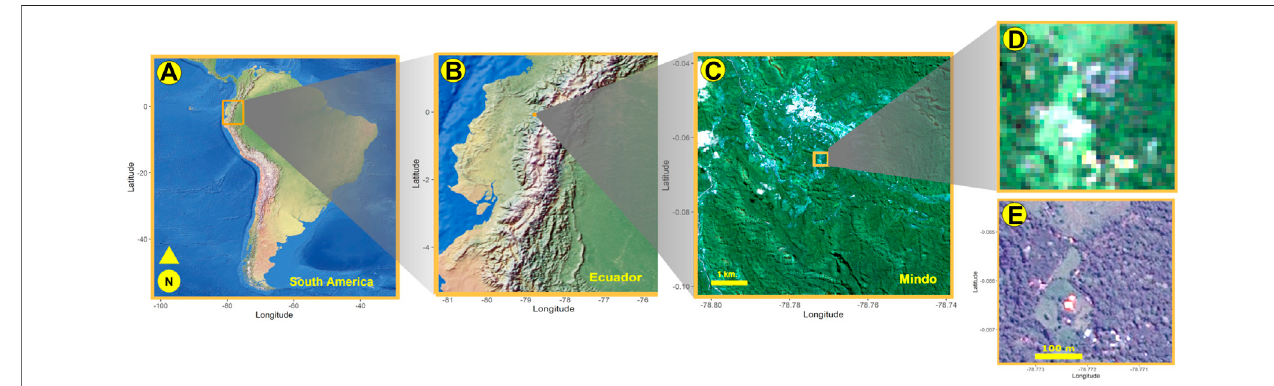
FIGURE 1 | (A) Running north and south across South America, the Andes supports 15 and 12 percent of globally known plant and vertebrate species, respectively. The study area is in northern Ecuador (B) , centered around a pueblo called Mindo, for which Sentinel-2 satellite rasters were cropped (C) . From these rasters, we extracted tiles of 38 × 38 pixel resolution (D) , with each pixel having a spatial resolution of 10 m 2 To manually classify individual pixels, we compared these Sentinel-derived tiles to higher resolution Airbus satellite images (E) .